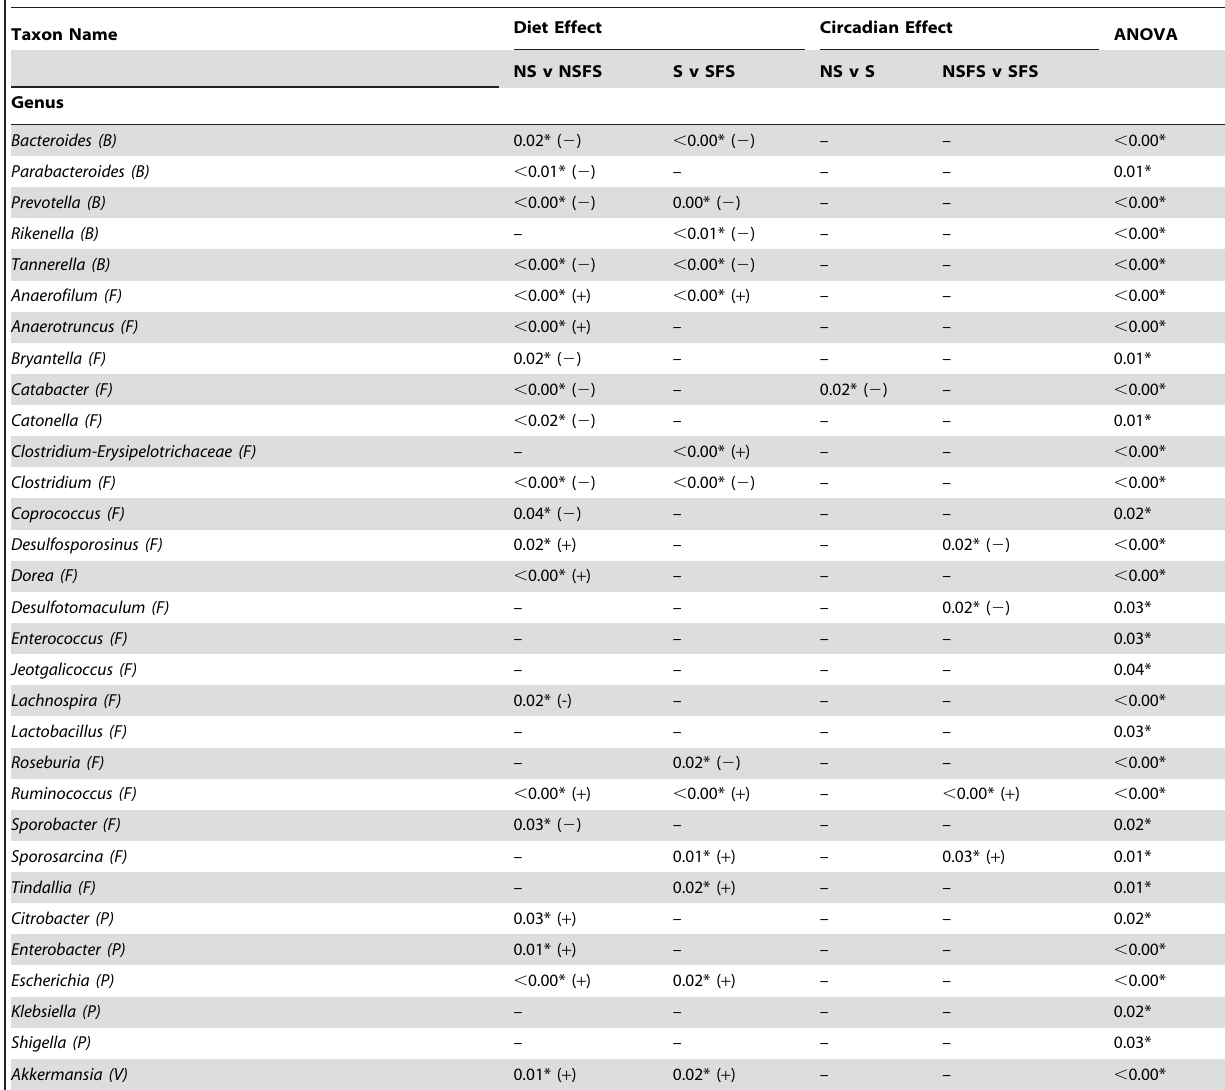
– , 0.00* P values indicated. Non-significant between group differences observed for: Acetanaerobacterium (F), Acetitomaculum (F), Acetivibrio (F), Acidovorax (P), Acinetobacter (P), Adlercreutzia (A), Aerococcus (F), Afipia (P), Alkaliphilus (F), Allobaculum (F), Anaerobranca (F), Anaerofustis (F), Anaeroplasma (T), Anaerosporobacter (F), Anaerostipes (F), Anaerovirgula (F), Anaerovorax (F), Anaplasma (P), Arcicella (B), Arthromitus (F), Asaia (P), Atopobium (A), Atopostipes (F), Bacillus (F), Barnesiella (B), Blastopirellula (Pl), Blautia (F), Brevibacterium (A), Butyricicoccus (F), Butyrivibrio (F), Caldicellulosiruptor (F), Caminicella (F), Candidatus Phytoplasma (T), Catenibacterium (F), Caulobacter (P), Coprobacillus (F), Cronobacter (P), Cryobacterium (A), Corynebacterium (A), Denitrobacterium (A), Desulfitobacterium (F), Desulfonispora (F), Edaphobacter (Ac), Eggerthella (A), Enhydrobacter (P), Enterorhabdus (A), Ethanoligenens (F), Eubacterium (F), Eubacterium (Erysipelotrichaceae) (F), Epulopiscium (F), Faecalibacterium (F), Finegoldia (F), Flavobacterium (B), Flexibacter (B), Frateuria (P), Fusobacterium (Fu), Gluconobacter (P), Haemophilus (P), Hespellia (F), Howardella (F), Hydrogenoanaerobacterium (F), Johnsonella (F), Lachnobacterium (F), Klebsiella (P), Lactococcus (F), Lactonifactor (F), Leptolyngbya (C), Methylobacterium (P), Moraxella (P), Odoribacter (B), Olsenella (A), Oribacterium (F), Oscillibacter (F), Oscillospira (F), Oxobacter (F), Pantoea (P), Paraeggerthella (A), Paraprevotella (B), Parasporobacterium (F), Peptococcus (F), Peptoniphilus (P), Peptostreptococcus (F), Pirellula (Pl), Pontibacter (B), Prosthecomicrobium (P), Pseudobutyrivibrio (F), Pseudoflavonifractor (F), Porphyromonas (B), Propionibacterium (A), Proteus (P), Pseudomonas (P), Ralstonia (P), Rhizobium (P), Robinsoniella (F), Roseburia (F), Ruminococcus (F), Slackia (A), Sphingobium (P), Sphingomonas (P), Sphingopyxis (P), Sporanaerobacter (F), Sporobacterium (P), Staphylococcus (F), Streptococcus (F), Streptomyces (A), Subdoligranulum (F), Sulfobacillus (F), Swaminathania (P), Syntrophomonas (F), Thiothrix (P), Turicibacter (F), Xanthomonas (P). Groups: NS, non-shifted standard chow diet; S, shifted standard chow diet; NSFS, non-shifted high-fat, high-sugar diet; SFS, shifted high-fat, high-sugar diet. Phylum: A, Actinobacteria; B, Bacteroidetes; C, Cyanobacteria; F, Firmicutes; Fu, Fusobacteria; P, Proteobacteria; Pl, Plantomycetes; T, Tenericutes; V, Verrucomicrobia. *, significant between group differences; –, not significant; ( + )/(-), indicates direction of the